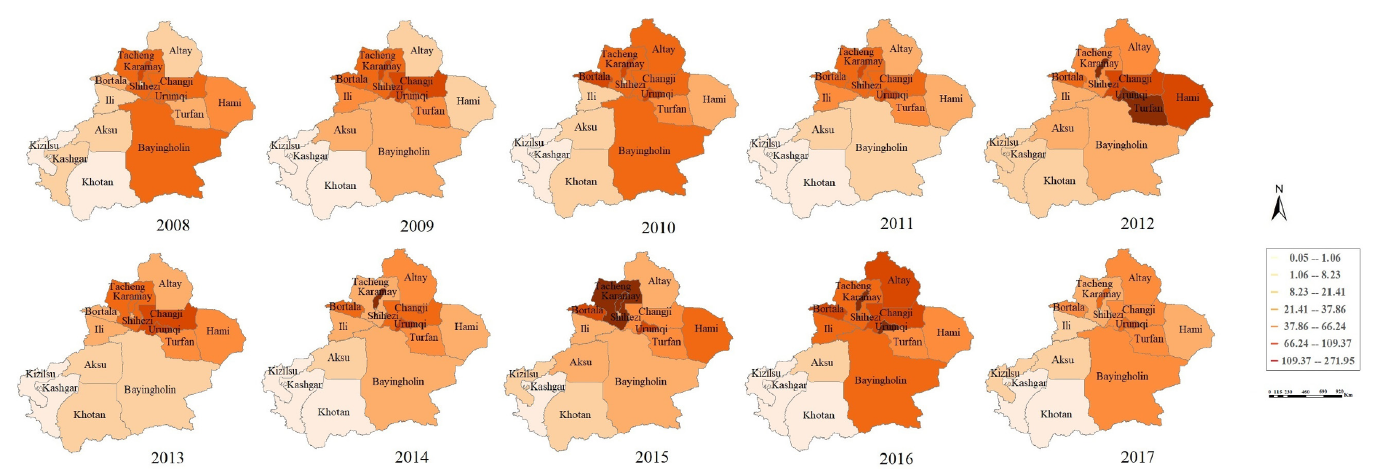
PLOS ONE | https://doi.org/10.1371/journal.pone.0254223 August 24,